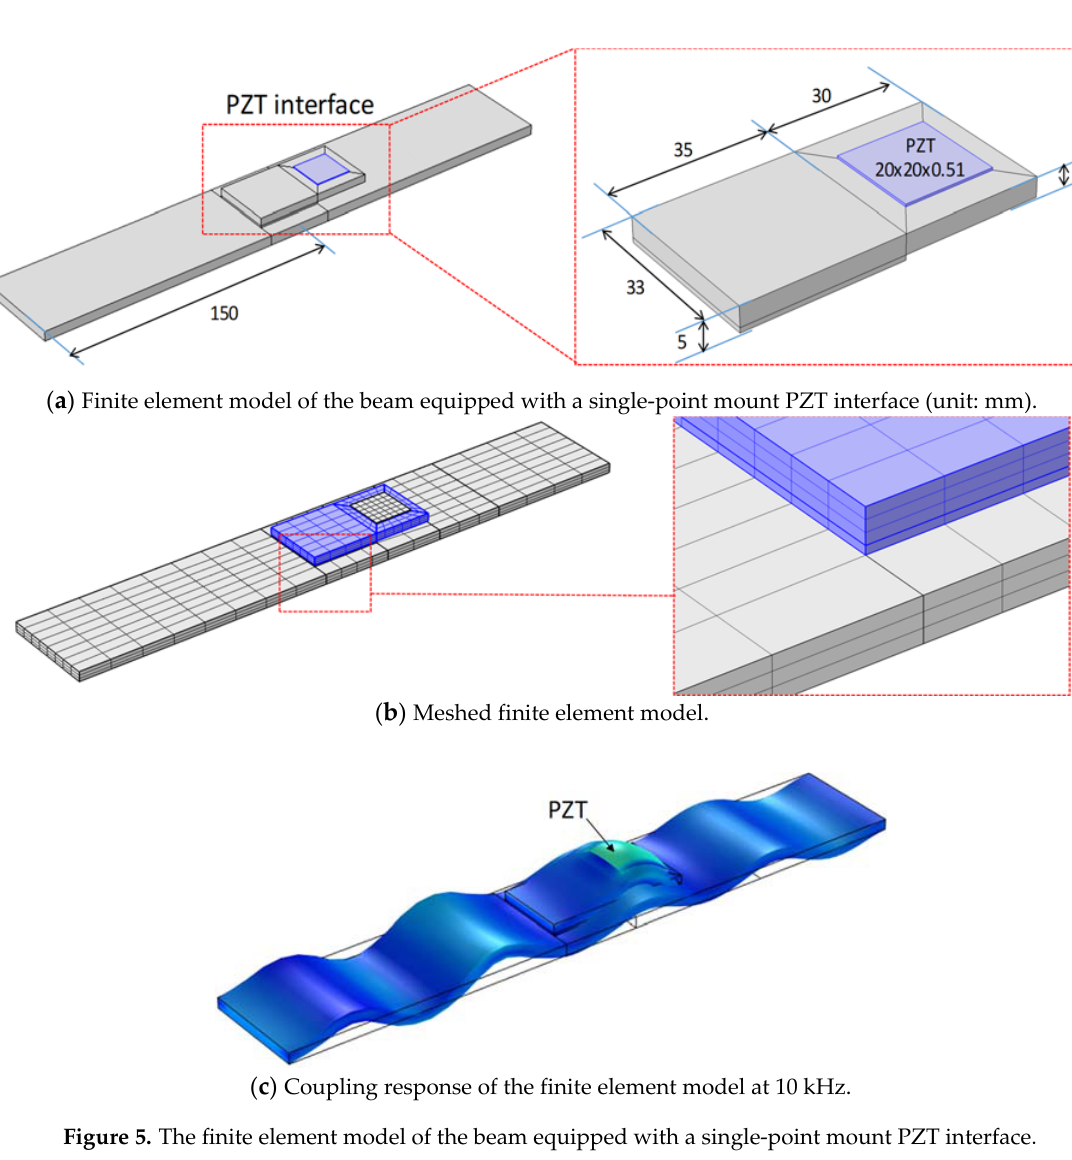
Figure 4. Geometrical parameters and boundary conditions of the host beam (unit: mm).